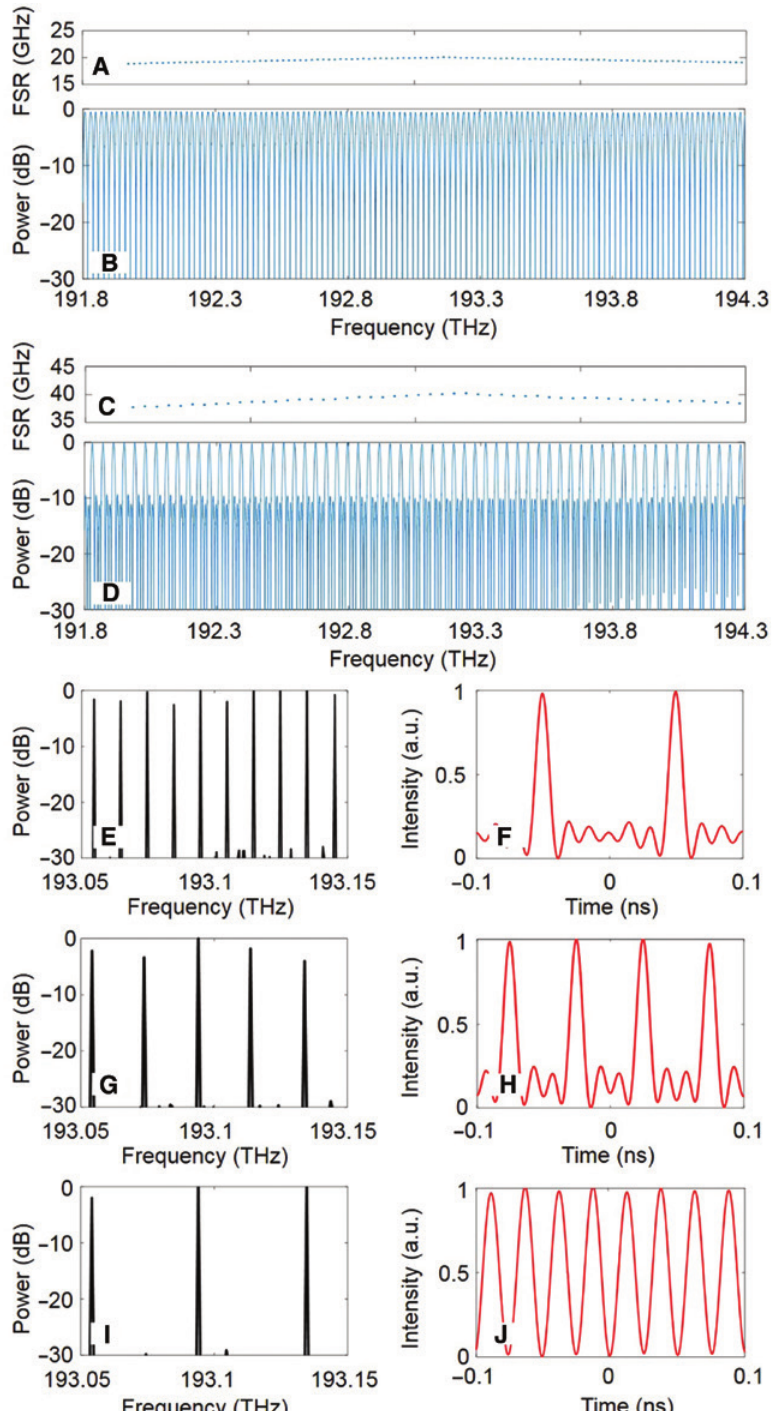
Figure 5: Measured filter responses and FSR uniformity across a bandwidth of 2.5 THz: (A, B) for a 2-tap 20-GHz-FSR filter topology; (C, D) for a 4-tap 40-GHz-FSR filter topology. Measured signal spectra and waveform obtained from a PD: (E, F) input clock signal at 10 Gpulses/s; (G, H) output clock signal at 20 Gpulses/s; (I, J) output clock signal at 40